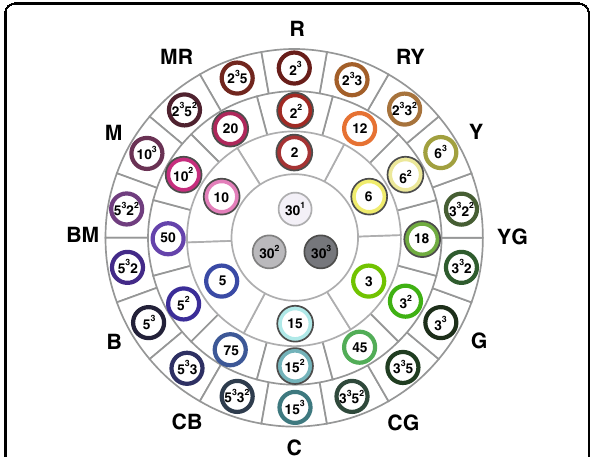
Fig. 1 A C 235 system with the fi rst 36 hue codes in a ring form. The basic C 235 color system has 36 hues/colors with 3 gray levels organized in 3 rings and 12 sectors – the inner circle has 3 gray codes surrounded by 36 hues/color codes spreading in 3 rings that belong to the 12 sectors outside the big circle